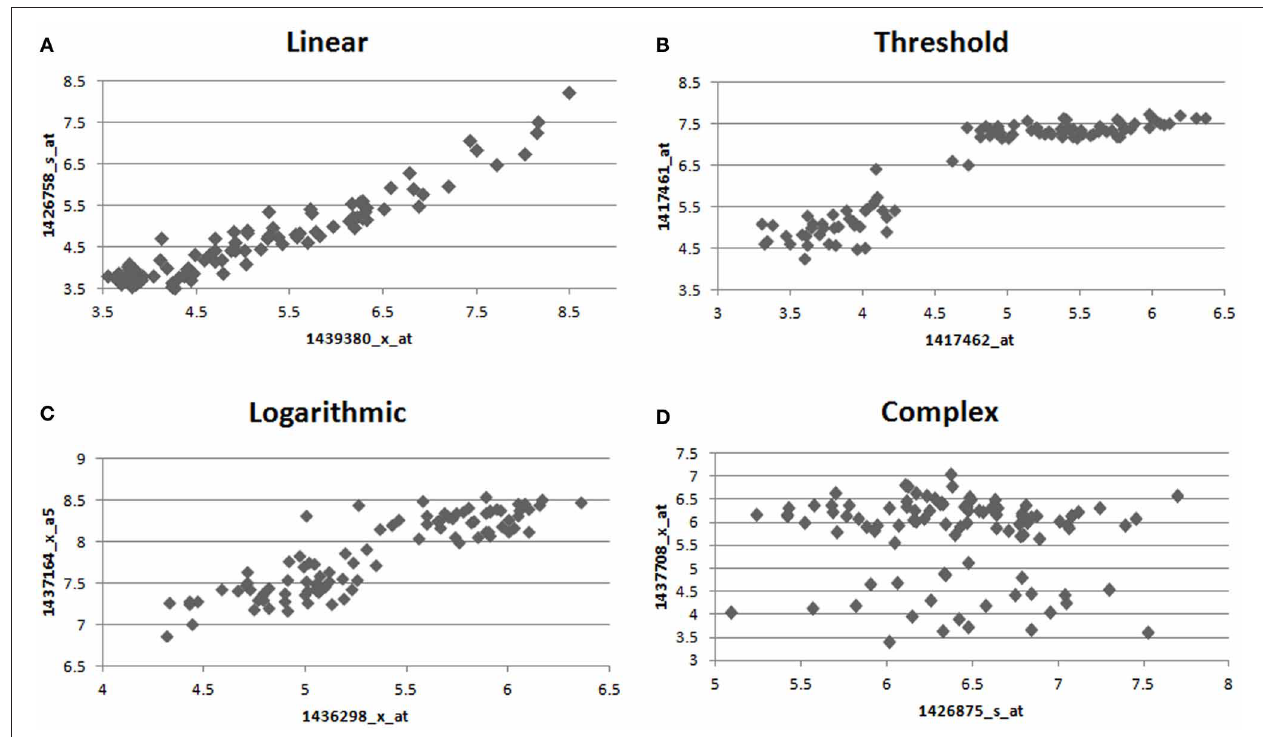
FIGURE 1 | Example relationships observed between pairs of genes in the macrophage dataset. We observe many different forms of relationships, such as (A) linear (B) high threshold (C) logarithmic